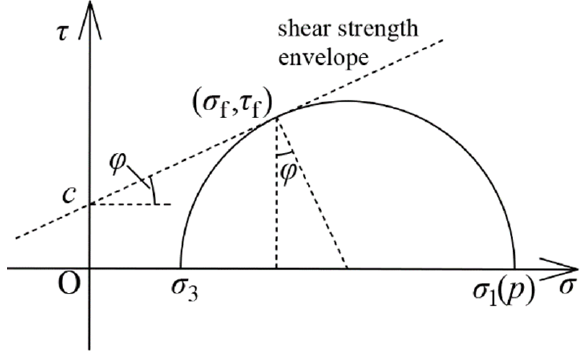
Figure 20. Mohr circle of soil stress.